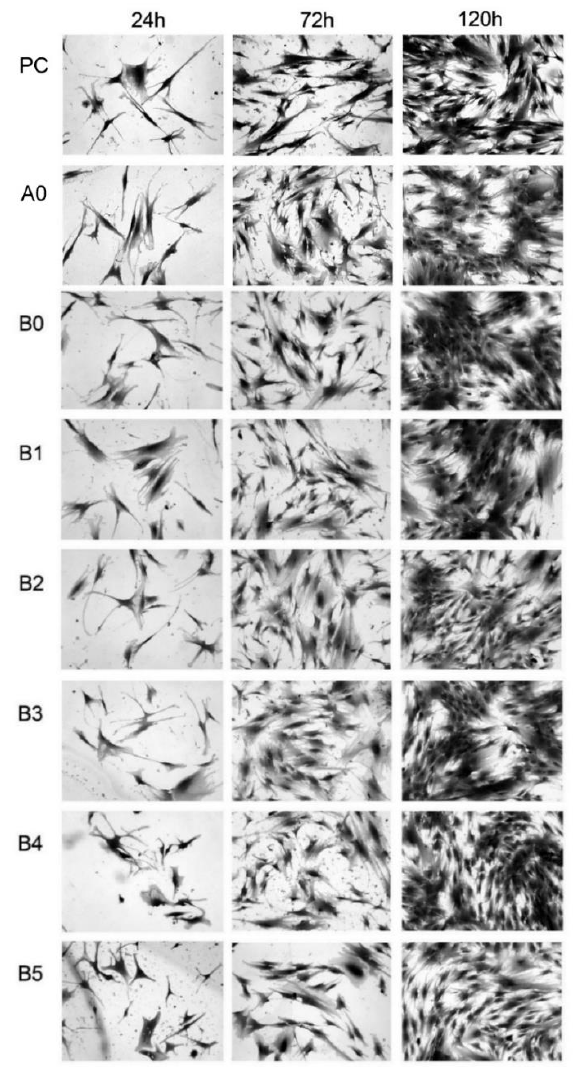
Figure 8. Morphology of the NHost cells cultured in different conditioned media for different times: 24, 72, and 120 h: positive control (PC), microcrystalline Ti (A0), ultrafine grained Ti23Zr25Nb alloy (B0), ultrafine grained Ti23Zr25Nb alloy electrochemically modified (B1) and Ti23Zr25Nb—9 wt.% 45S5 Bioglass (B2), Ti23Zr25Nb—9 wt.% 45S5 Bioglass—1 wt.% Ag (B3), Ti23Zr25Nb—9 wt.% 45S5